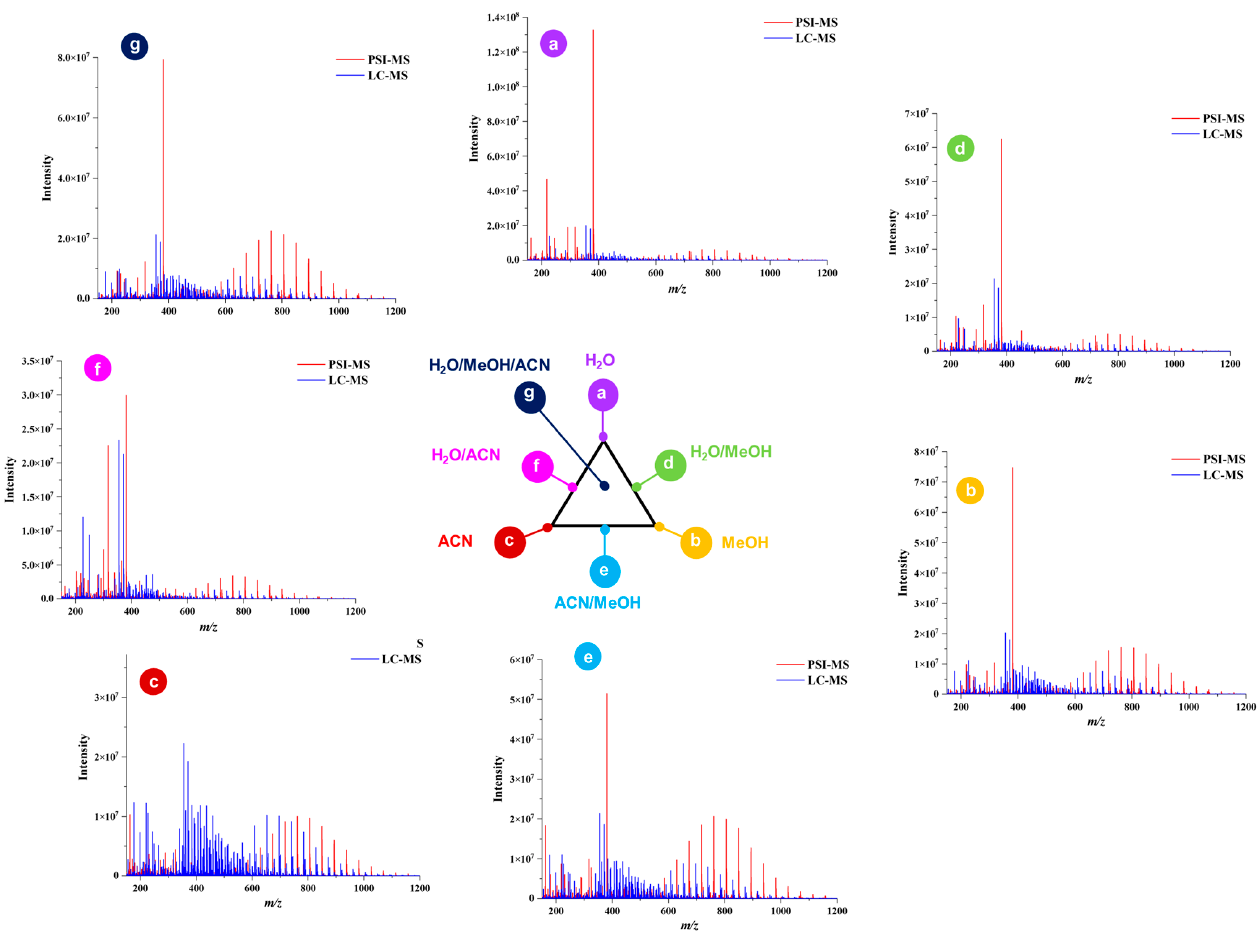
9 of 18 Figure 1. ( A ) Circle diagrams illustrate the percentages of unique metabolites obtained by classical molecular networking (MN), Dereplicator+, Moldiscovery, and NAP fusion from LC-MS spectra of cupuassu ( T. grandiflorum ) pulp extracts. ( B ) Impact of solvent used on the percentage of major chem- ical classes detected by LC-HRMS/MS analysis in positive ion mode ESI incupuassu pulp extracts. Comparison of PSI-HRMS/MS and LC-HRMS/MS in metabolic profiling of cupuassu pulp extracts showed, that LC-HRMS/MS detected more secondary metabolites than PSI-